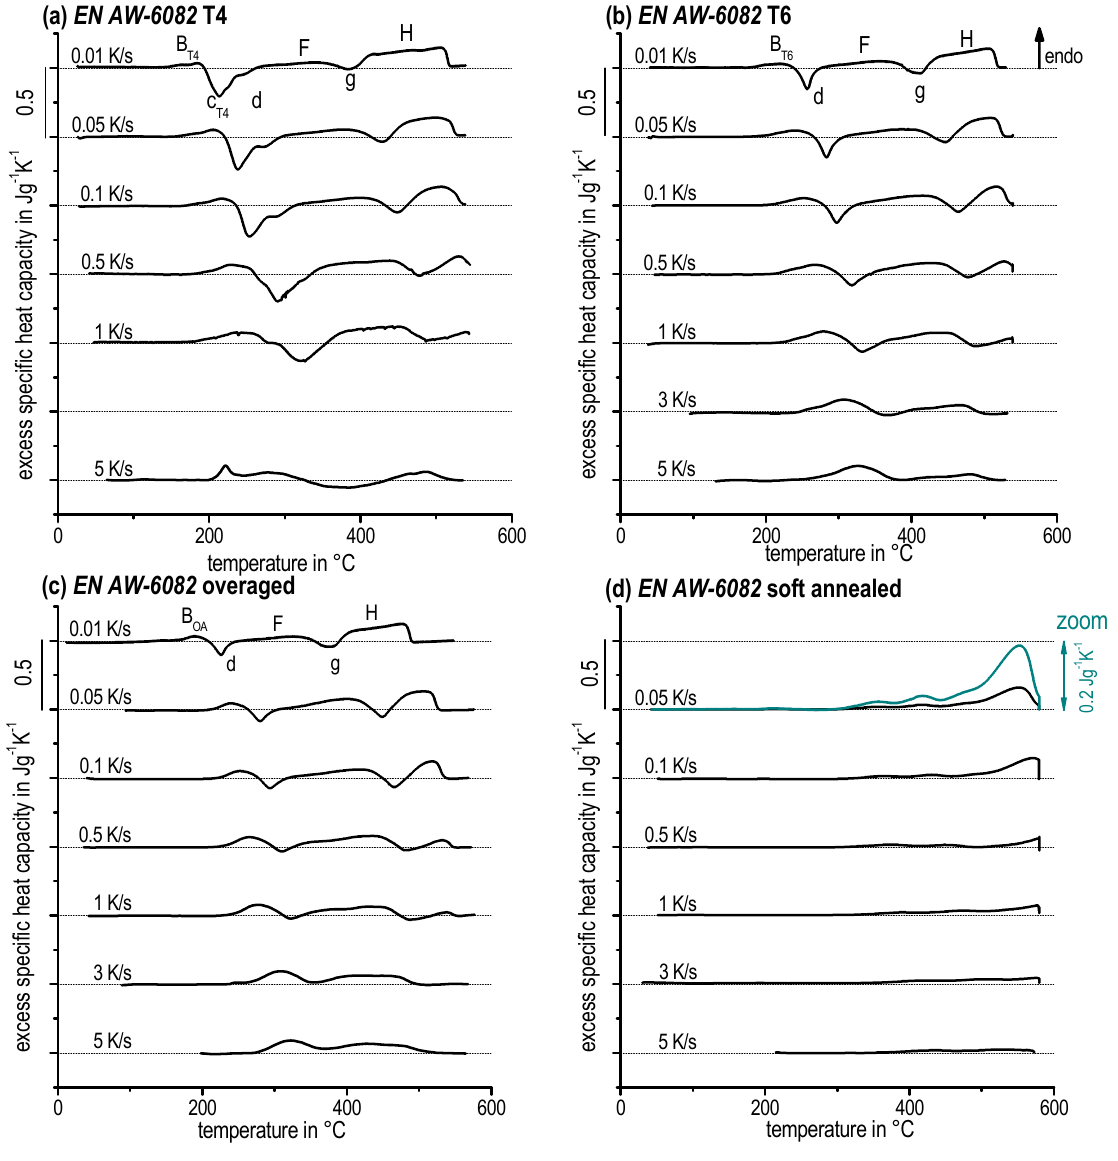
F igure 7. Continuous heating curves for EN AW-6082 with different initial conditions ( a ) T4. ( b ) T6. ( c ) Overaged. ( d ) Soft